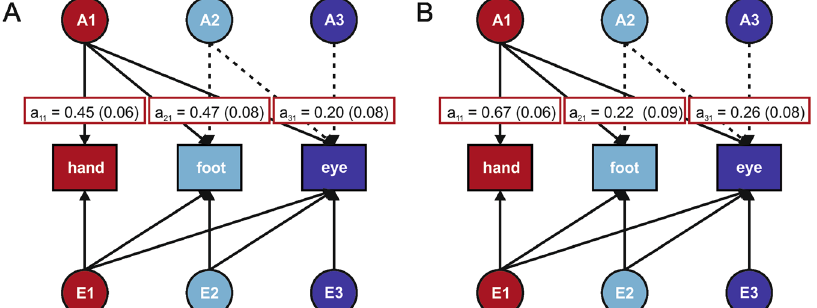
Fig. 3 Results of SEM analyses between laterality phenotypes. A Results of GRM-SEM in ALSPAC. B Results of behavioural SEM in the Hong Kong cohort. Circles on top and bottom indicate genetic ( A ) and environmental ( E ) factors, respectively. Coloured boxes indicate the phenotypes. Solid lines indicate signi fi cant path coef fi cients, dotted lines indicate non-signi fi cant path coef fi cients. White boxes indicate path coef fi cients and standard errors (SE) for signi fi cant genetic factors. The contour of the white boxes indicates the genetic factor (A1 in all cases).